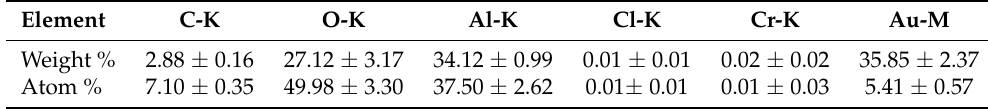
Table 3. The chemical analysis of the AAO Cl+Cr membrane.